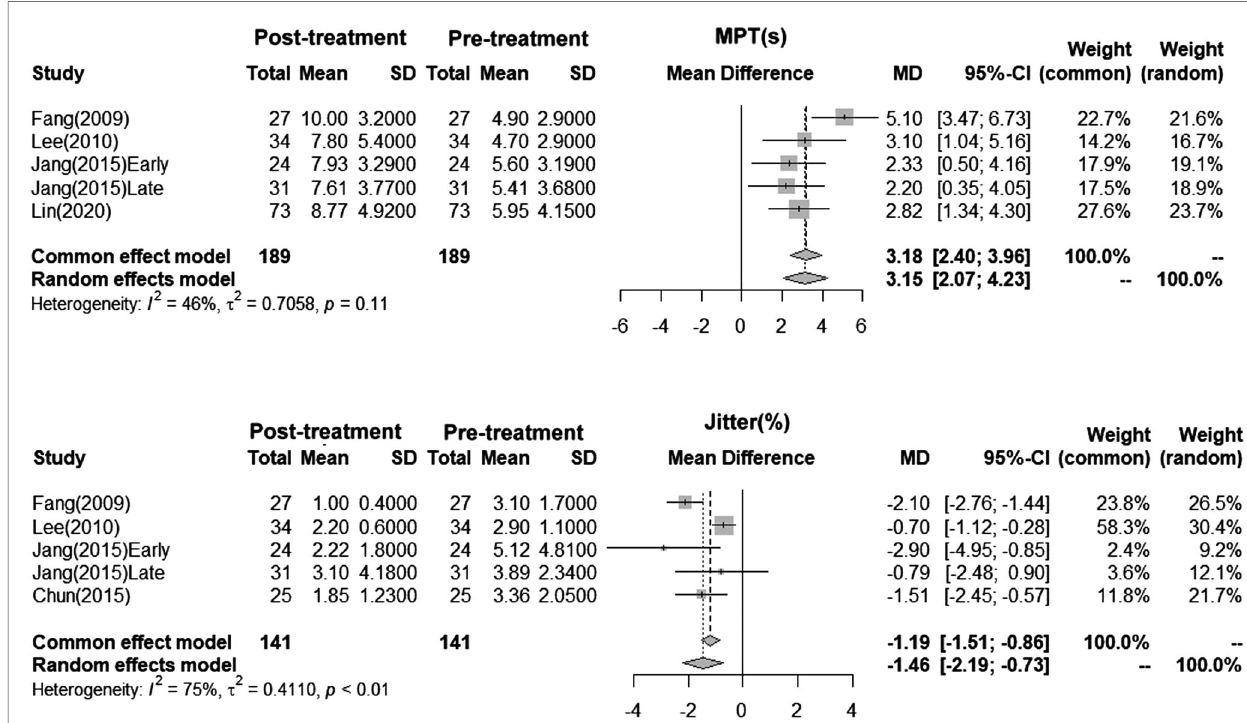
FIGURE 2 | Forest plots show the results of meta-analysis from the included research. Fixed effect (i.e., common effect) model was selected for statistical inference when heterogeneity between research was non-signi fi cant, whereas random effects model was applied in presence of signi fi cant